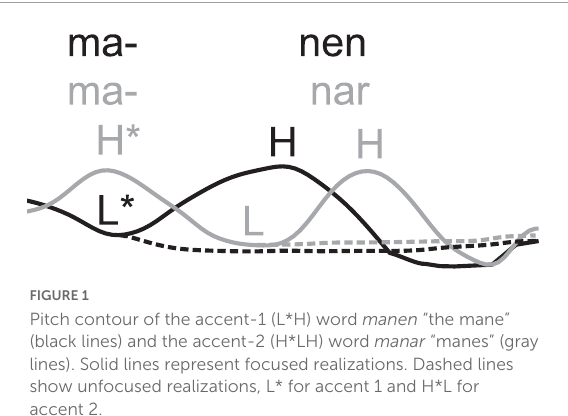
FIGURE1 Pitch contour of the accent-1 (L*H) word manen “the mane” (black lines) and the accent-2 (H*LH) word manar “manes” (gray lines). Solid lines represent focused realizations. Dashed lines show unfocused realizations, L* for accent 1 and H*L for accent